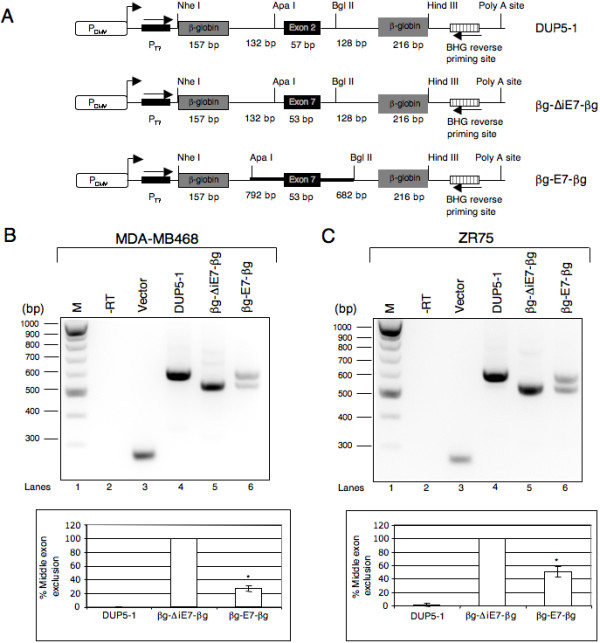
Regulatory elements in Exon 7 and flanking intronic sequences are important for controlling CEACAM1 alternative splicing. (A) The DUP5-1 minigene shown here contains three exons and two introns derived from human β-globin gene and is essentially identical to previously described version [46] except that vector backbone is pcDNA 3.1/Myc-His(-) C. The middle exon is a chimera of β-globin exon 1 and 2. The name of each minigene and exon and intron sizes are indicated. Minigene βg-ΔiE7-βg is a derivative of DUP5-1 in which the middle exon 2 is replaced by exon 7 of CEACAM1. Minigene βg-E7-βg was created by digesting pDUP5-1 with ApaI and BglII and inserting PCR amplified CEACAM1 fragment that contains exon 7 and the flanking introns 6 and 7 (thick line) except first 150 bp in intron 6 and last 94 bp in intron 7. (B and C) RT-PCR analysis of MDA-MB468 and ZR75 cells transfected with the indicated minigenes or empty vector. -RT represents omission of reverse transcriptase during cDNA synthesis. The data shown is representative of three independent experiments. Bar diagrams represent the mean ± SD of at least three independent experiments. *P < 0.001 versus DUP5-1.